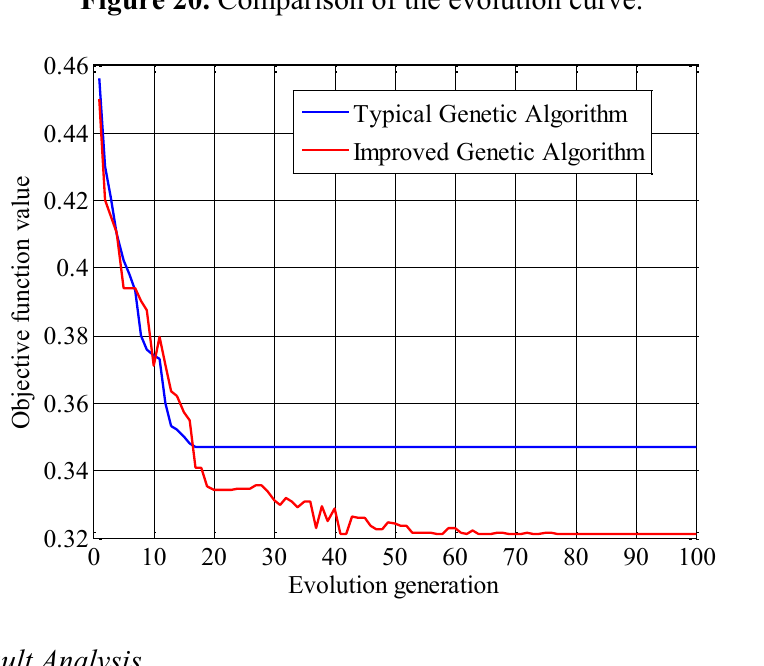
Figure 20. Comparison of the evolution